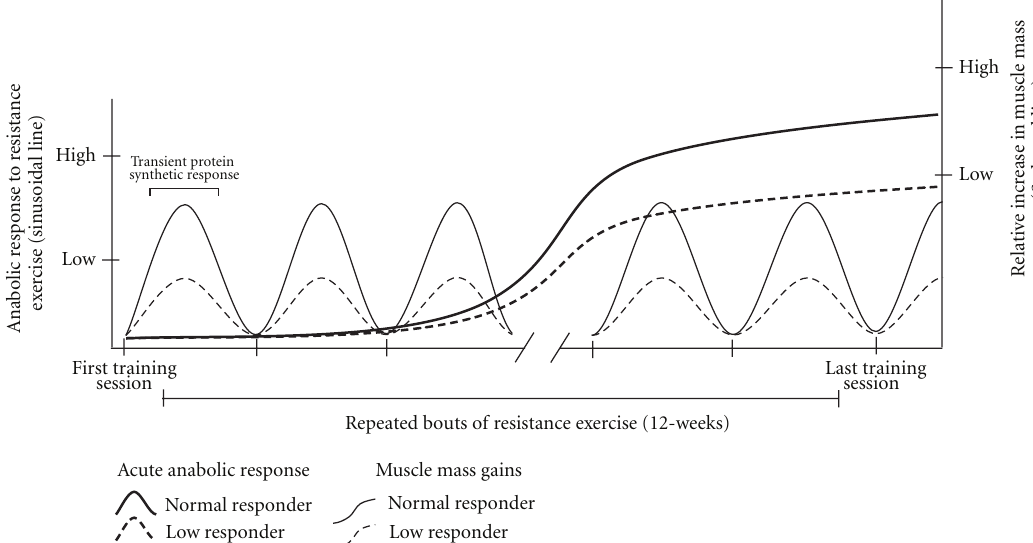
Figure 2: Theoretical model of anabolic response to resistance exercise in “normal” and “low responders”. Each sinusoidal line represents anabolic response (i.e., protein synthesis) to a bout of resistance exercise in normal (solid) and low (dashed) responders. S-shaped line represents muscle mass gains following 12 weeks of repeated bouts of resistance exercise in normal (solid) and low (dashed)